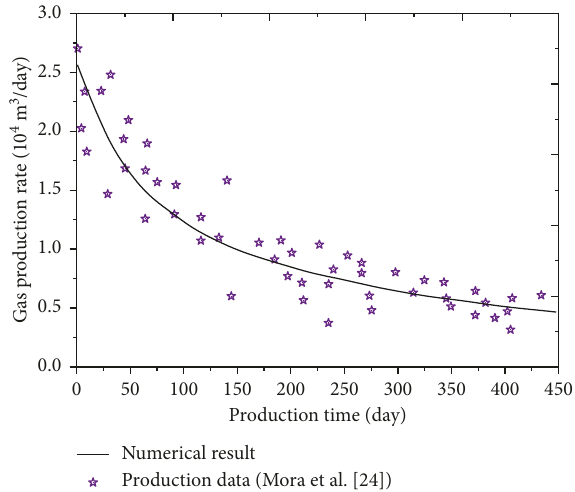
Figure 3: Comparison between numerical result and field test.